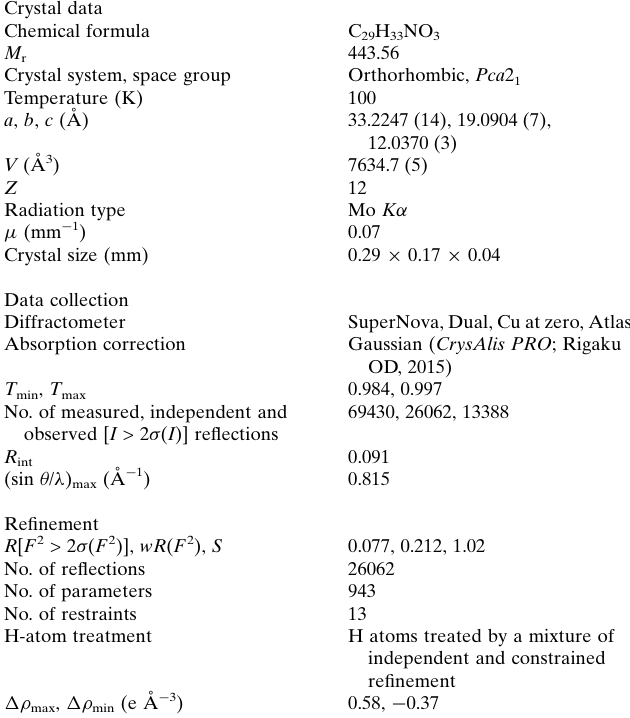
Table 4 Experimental details. Crystal data Chemical